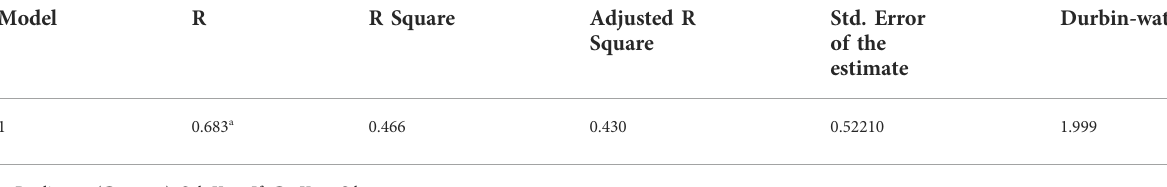
TABLE 12 Summary model corresponding to the dependent variable for Pi.